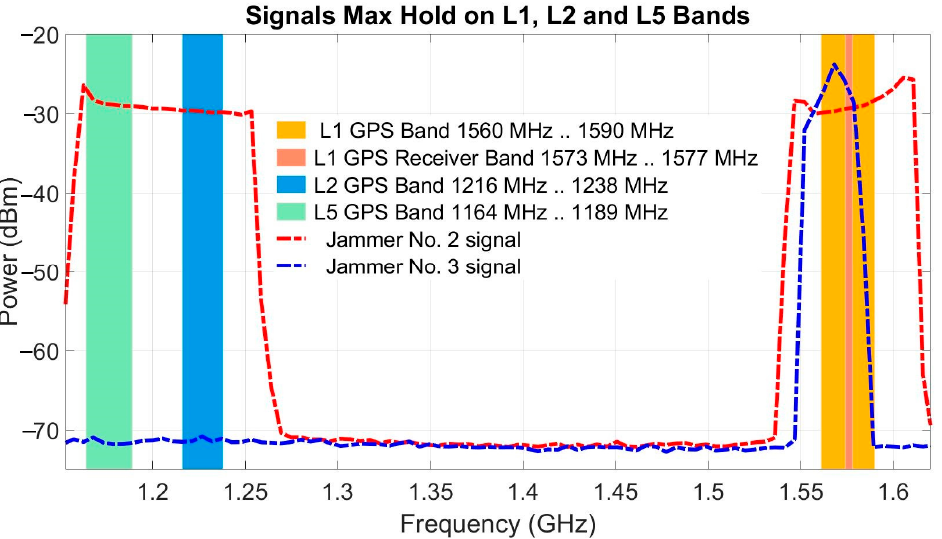
Figure 3 . Comparison of peak values, i.e., max hold throughout power spectrums assigned to GPS of jammers 2 and 3.